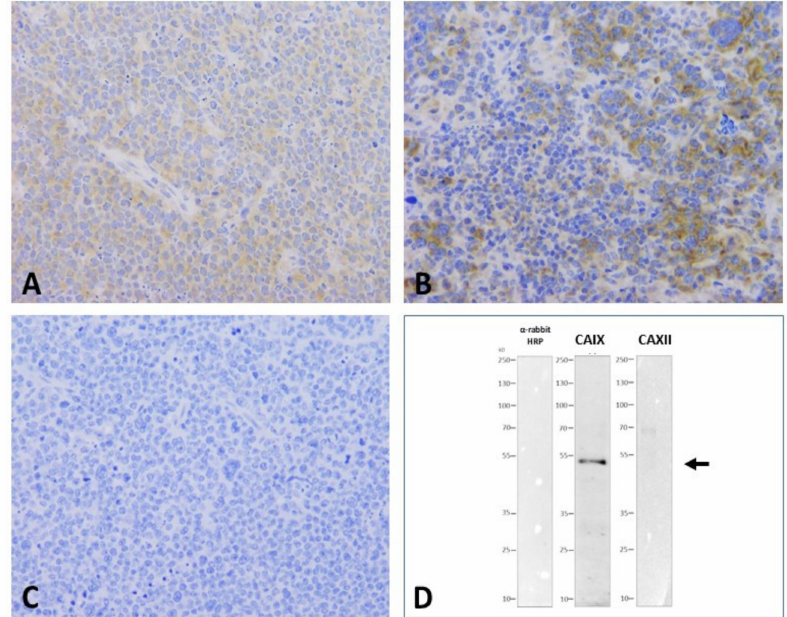
Figure 4. CAIX and CAXII presented by immunohistochemistry and Western blotting of A20 murine lymphoma grafts. Uniform weak cytoplasmic / membrane CAIX positivity of lymphoma cells ( A ); heterogeous IHC reaction with slight increase in the giant cell component following CHOP treatment, note negativity for the immune infiltrate ( B ); negative IHC staining for CAXII ( C ) (40 × magnification). Western blot of A20 lymphoma cell lysate presenting a single specific band at 53–55 kDa for CAIX (center lane) and no signal for the CAXII protein ( D , right lane, arrow). No unspecific signal by the detection system (based on anti-igG-HRP) applied in the absence of the primary antibodies was seen (negative control, left